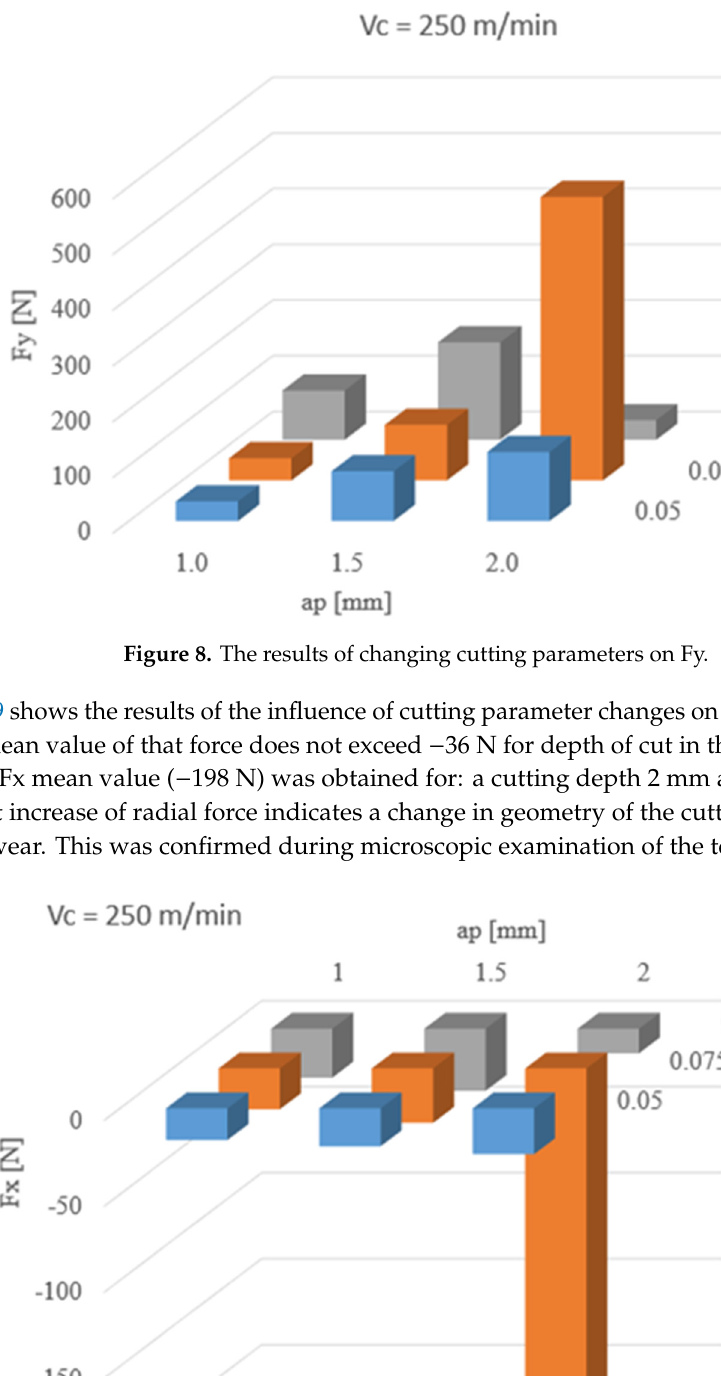
Figure 9. The results of changing cutting parameters on Fx.